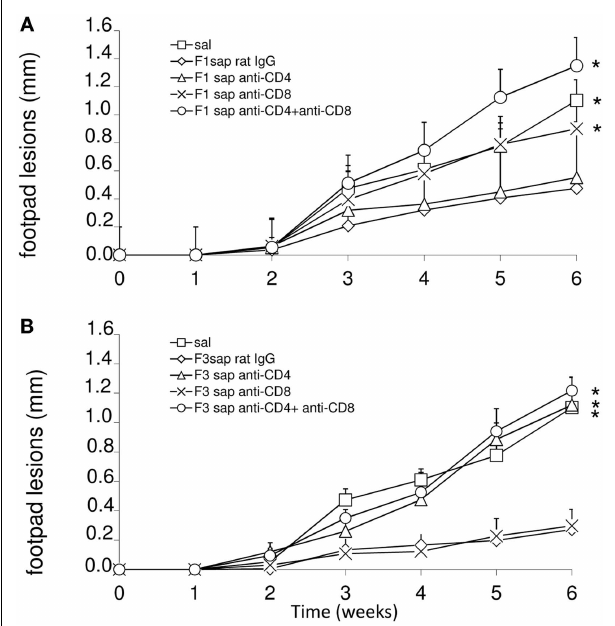
FIGURE 3 | In vivo depletion assay with anti-CD4 and anti-CD8 monoclonal antibodies. Mice were challenged with L. amazonensis after vaccination with F1sap (A) and F3sap (B) vaccines and treated with rat serum, anti-CD4 + or anti-CD8 + , or the combination of anti-CD4 and anti-CD8 MAbs. Results are shown as the mean ± SD of the footpad measurements of one experiment (four to five animals per treatment) along the time. * p < 0.05, different from the F1sap (A) and F3sap (B)